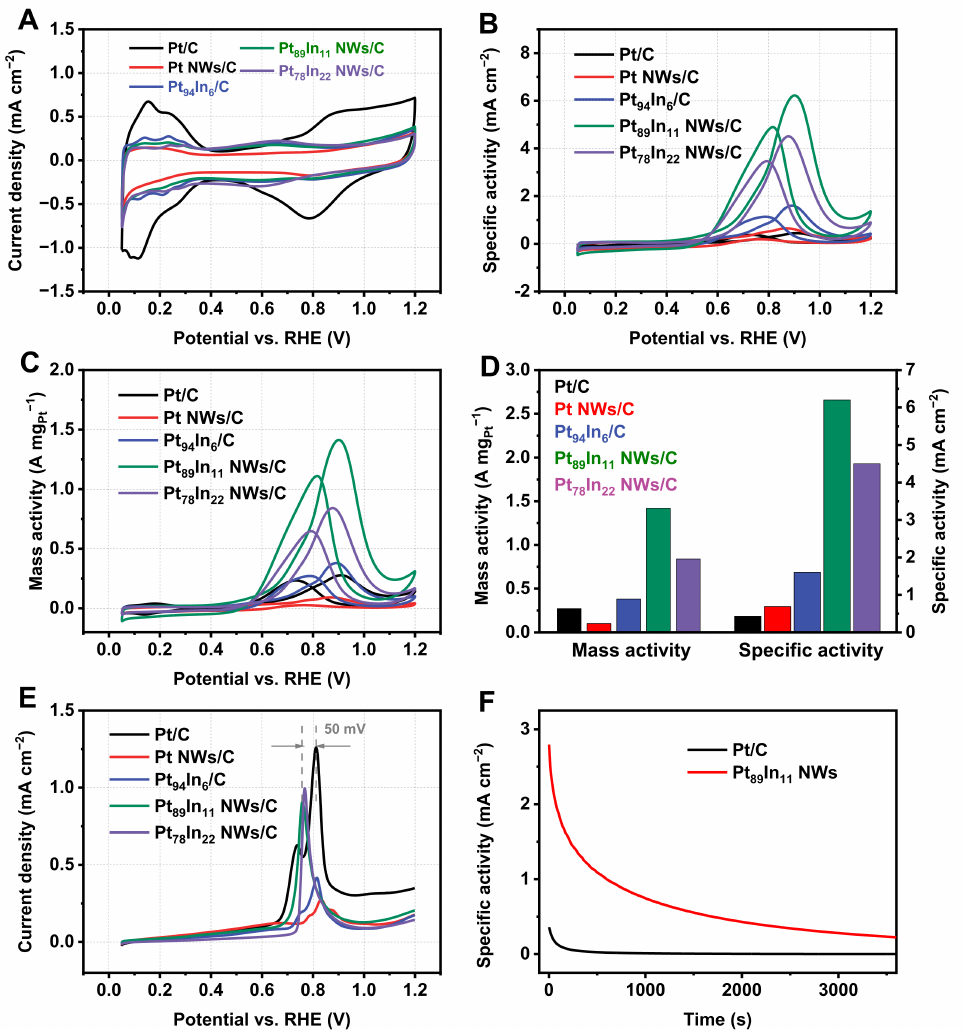
Figure 4. ( A ) CV curves of the studied electrocatalysts in 0.1 M HClO 4 . ( B ) ECSA normalized and ( C ) mass normalized CV curves of the studied electrocatalysts in 0.1 M HClO 4 + 0.5M methanol. ( D ) Comparison of MA and SA of the studied electrocatalysts. ( E ) CO stripping curves of the studied electrocatalysts. ( F ) I-t curves of Pt/C and Pt 89 In 11